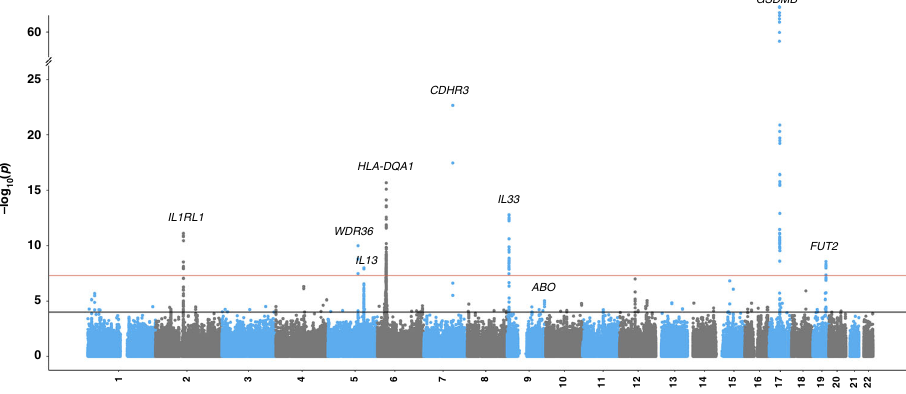
Fig. 1 Manhattan plot depicting loci associated with childhood asthma with severe exacerbations in the discovery genome-wide meta-analysis. Association P value (suggestive threshold line in black): 1 × 10 − 4 , (genome-wide threshold line in red): 5.0 × 10 − 8 . Associations are from fi xed-effect meta- analyses based on logistic regression models adjusted for sex and the fi rst ten principal components. N discovery = 68,281 individuals ( N COPSAC and N iPSYCH =